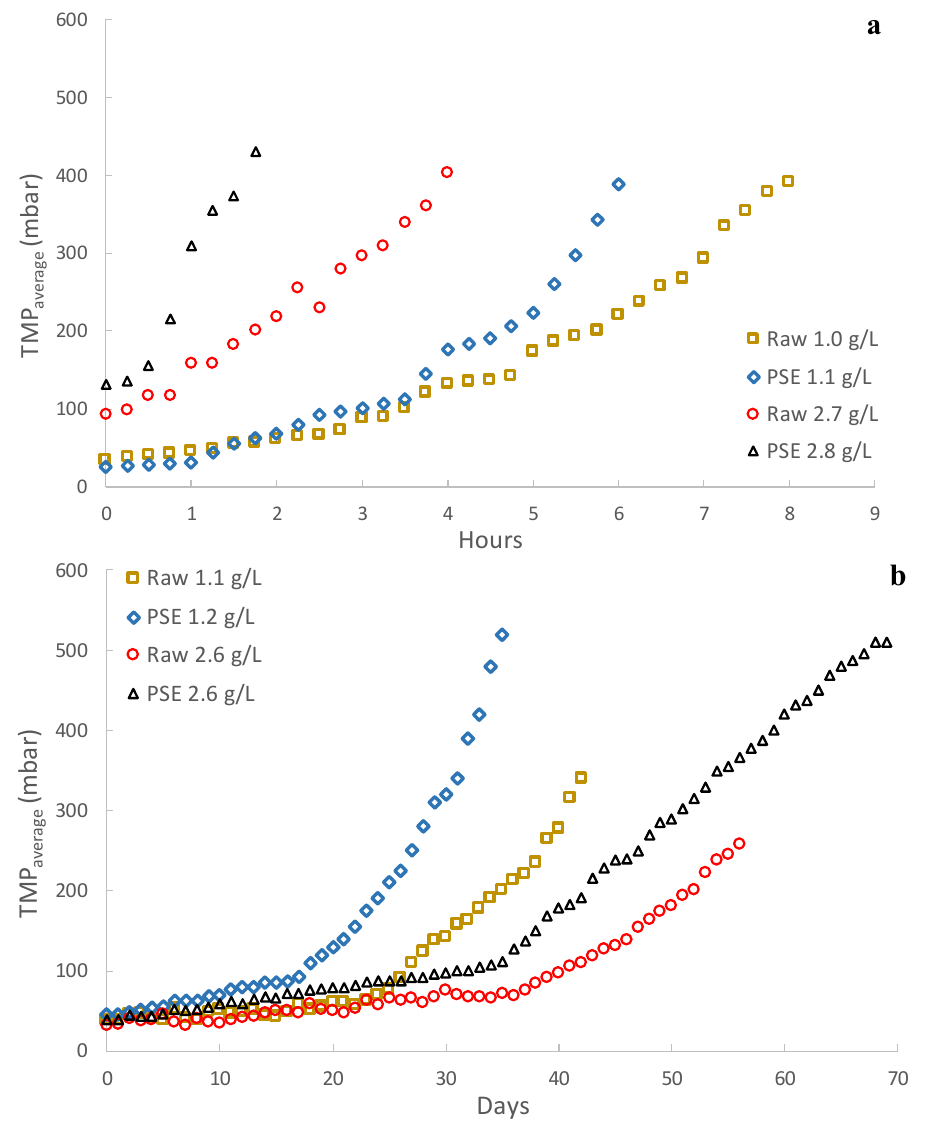
Figure 3. Direct municipal wastewater filtration performance: ( a ) microfiltration membrane and ( b ) ultrafiltration membrane. Note that the legend shows the influent treated together with the average operating total suspended solids concentration. Raw: influent municipal wastewater after a classic pre-treatment (screening and sieving, desanding and degreasing). PSE: effluent of the full-scale wastewater treatment plant primary settler. Table 3. Irreversible fouling growth rate during the ultrafiltration membrane operation. Sewage